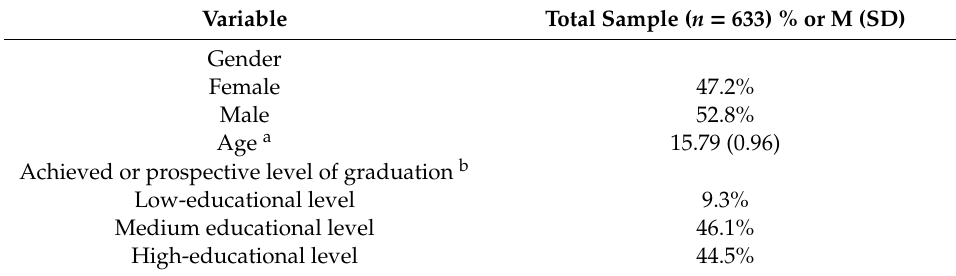
Table 1. Sociodemographic characteristics of the sample.